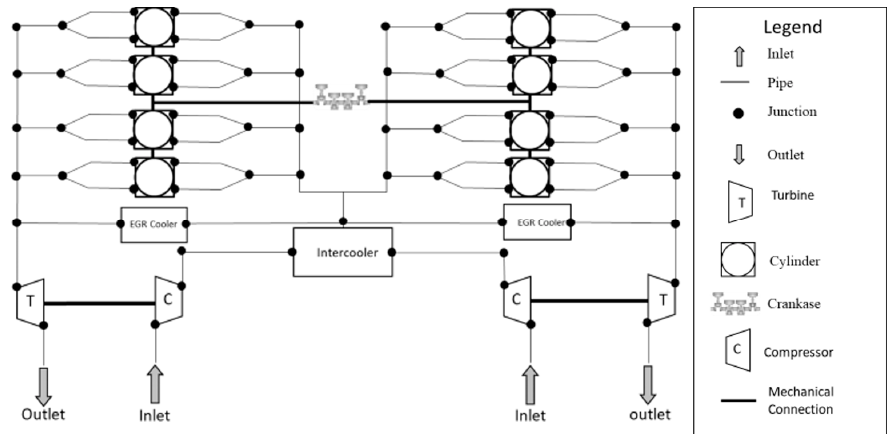
Figure 3. Detailed model of HD diesel engine.